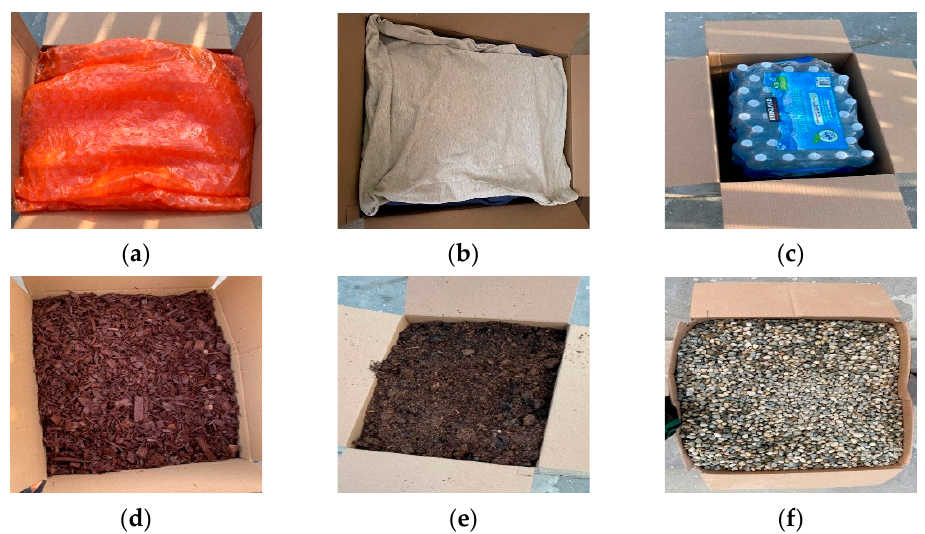
Figure 6. Materials used for range-profile capture: ( a ) bubble-wrap; ( b ) clothes; ( c ) water; ( d ) mulch; ( e ) soil; and ( f ) granite pebbles.